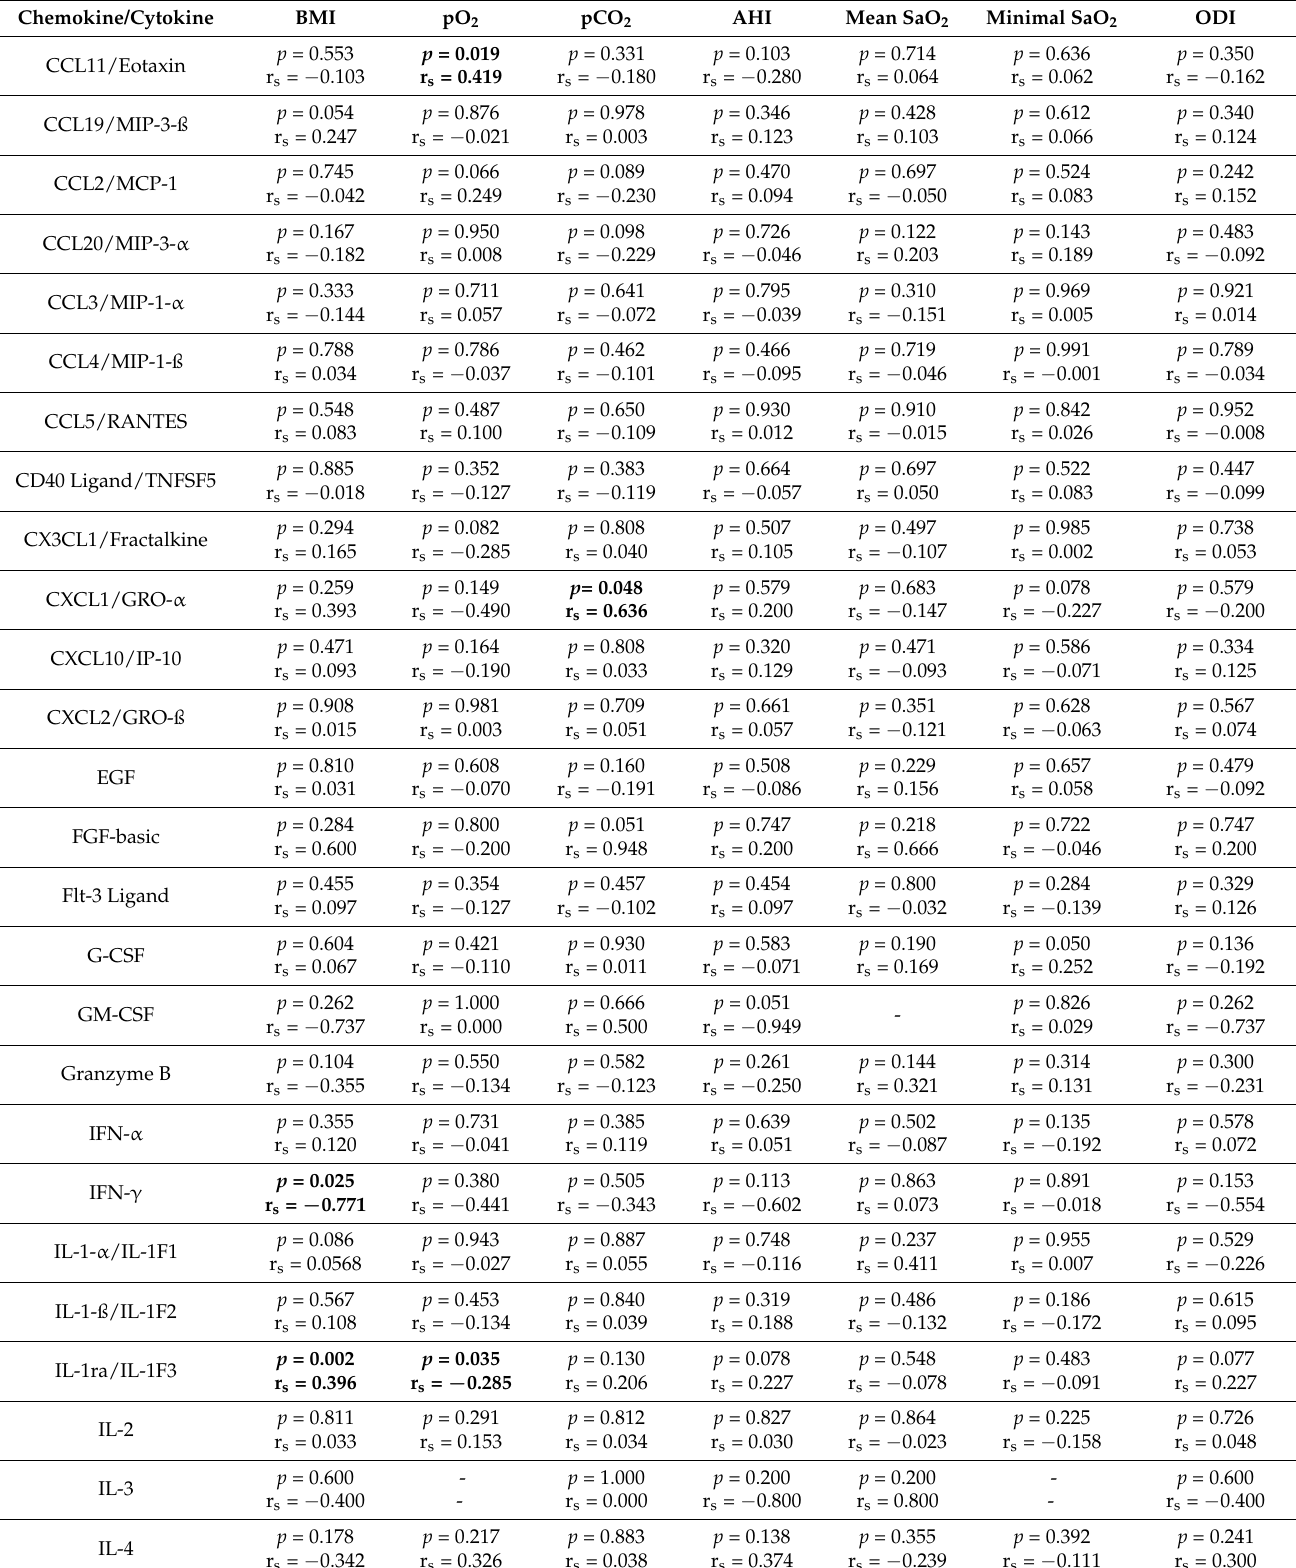
Table 6. Correlations of chemokine/cytokine levels with clinical